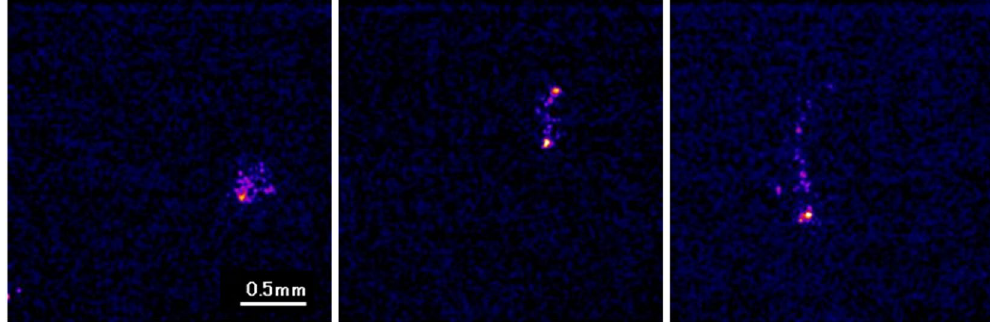
Figure 8. Images of typical beta particles measured by developed radiation imaging system.